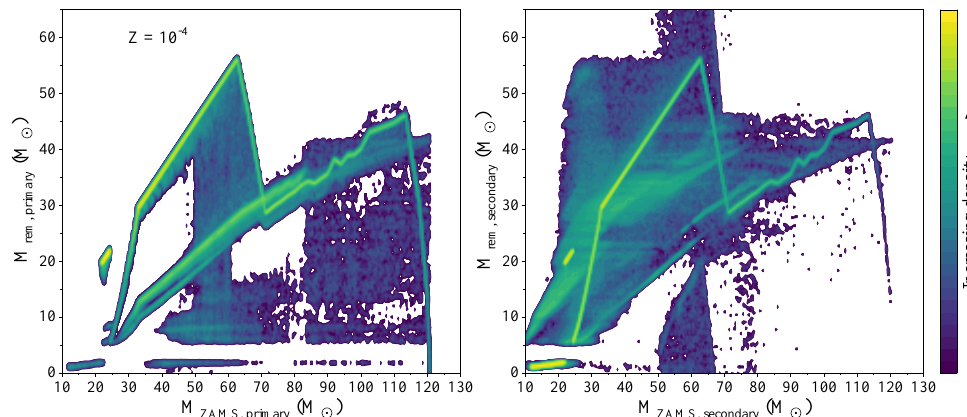
Figure 7. Mass of the compact remnant as a function of the ZAMS mass of its progenitor. The figure has been obtained evolving a population of 10 7 binary stars at Z = 10 − 4 with the SEVN code, as in Spera et al. [222]. The masses of the primary stars are drawn from a Kroupa initial mass function [203] while the secondary masses, initial orbital periods and eccentricities are distributed according to [354]. The left (right) panel refers to primary (secondary) stars, i.e., those that have the largest (smallest) M ZAMS in each binary. The color map represents the number of compact objects at each location of the plot, with counts that increase going from dark to light